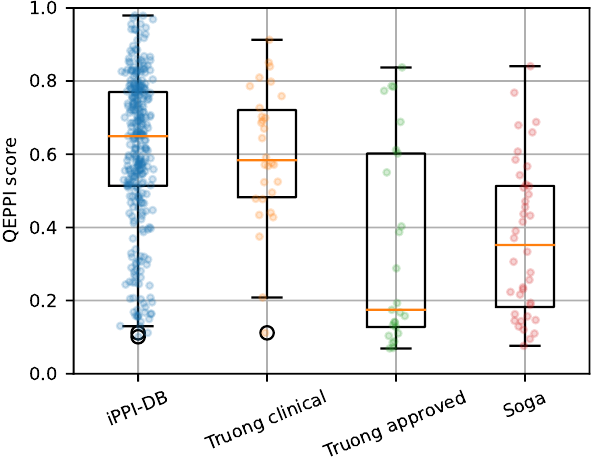
Figure 5. Distribution of QEPPI with respect to compounds in the clinical phase or approved PPI- targeting compounds dataset. The Truong clinical and Truong approved datasets represent clinical and FDA-approved PPI-targeting compound data, respectively. The iPPI-DB and Soga datasets represent positive and negative controls, respectively. The jitter overlaid on the boxplots shows the QEPPI scores for all samples in each data